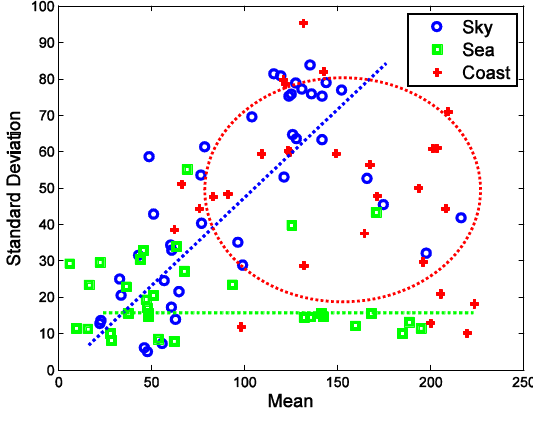
Figure 6. Distribution of the thermal average intensity and standard deviation for each